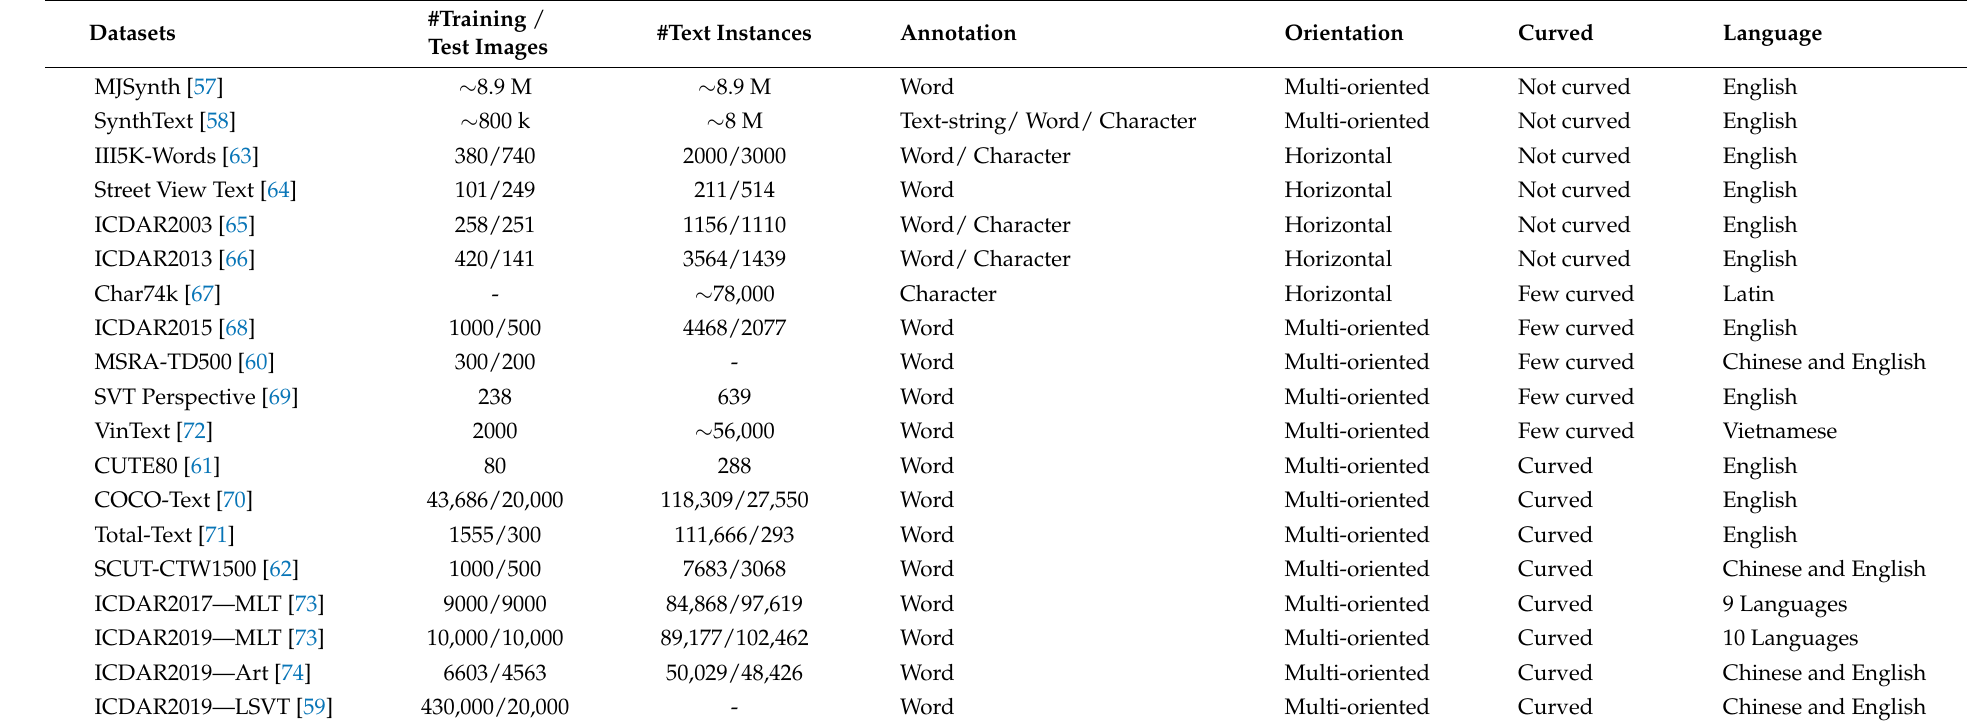
Table 3. Comparison between Scene Text